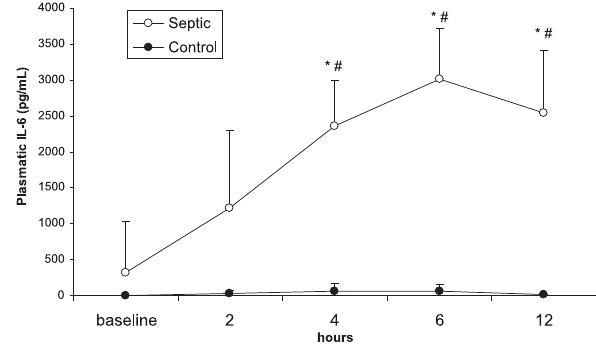
Figure 1 - Time course of plasma concentrations of interleukin-6 (IL-6) in septic and control animals. All values are given as mean ± SD. # P < .05